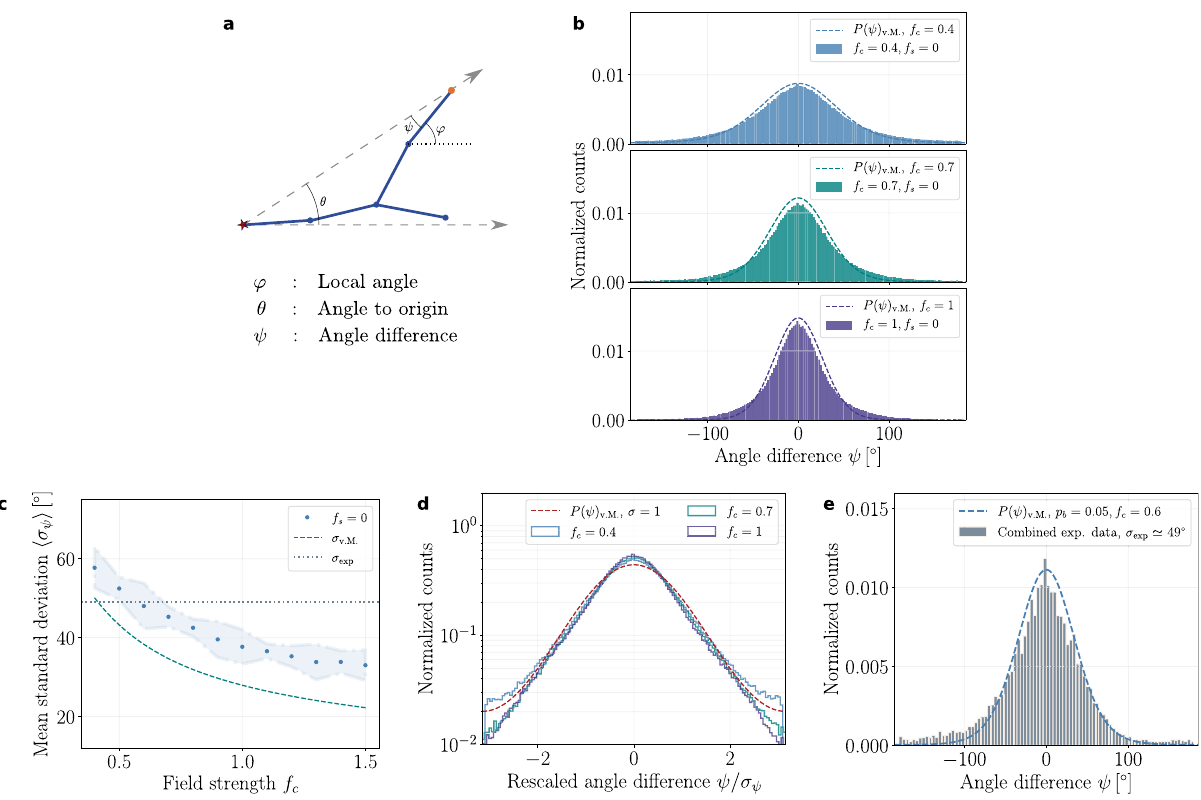
Fig. 3 Continuum model predicts the alignment of branch segments along the external fi eld both for simulation and experimental data. a Schematic of branch segments in a radial external fi eld (dashed arrows) highlighting three distinct angles: The local angle φ of a branch segment with an active tip (orange node), the angle to origin θ (denoted by the star symbol, which determines the extrinsic guidance direction at this point), and the angle difference ψ ≡ φ − θ (which tends to be minimized by extrinsic/global guidance). b Normalized histograms of the angle difference ψ for different values of f without self-avoidance ( f s = 0). The histograms (solid bars) are well-approximated by von Mises distributions (dashed lines) as for the local angle φ in a linear gradient (Fig. 1), and as predicted by the continuum model (with D ≃ 0.04 and μ ≃ 0.2). c Mean standard deviations (SDs) 〈 σ ψ 〉 of the angle difference ψ obtained from simulations are close to the mean SD of the experimental data (dotted horizontal line) for an external fi eld strength of f c = 0.6. For comparison, the scaling of SD as a function of f c predicted by the von Mises distribution is displayed (dashed line). d Histograms of angle difference ψ rescaled by their corresponding SDs σ ψ (solid lines) are well-approximated by the von Mises distribution with unit SD (dashed line). e Angle difference distribution obtained from the experimental data from n = 8 networks (solid bars) compared with the von Mises distribution predicted by the theory for an external fi eld strength of f c = 0.6 (dashed line). The latter value is inferred from the matching of theoretical and experimental values of the SDs displayed in ( c ), and no other fi t parameter is